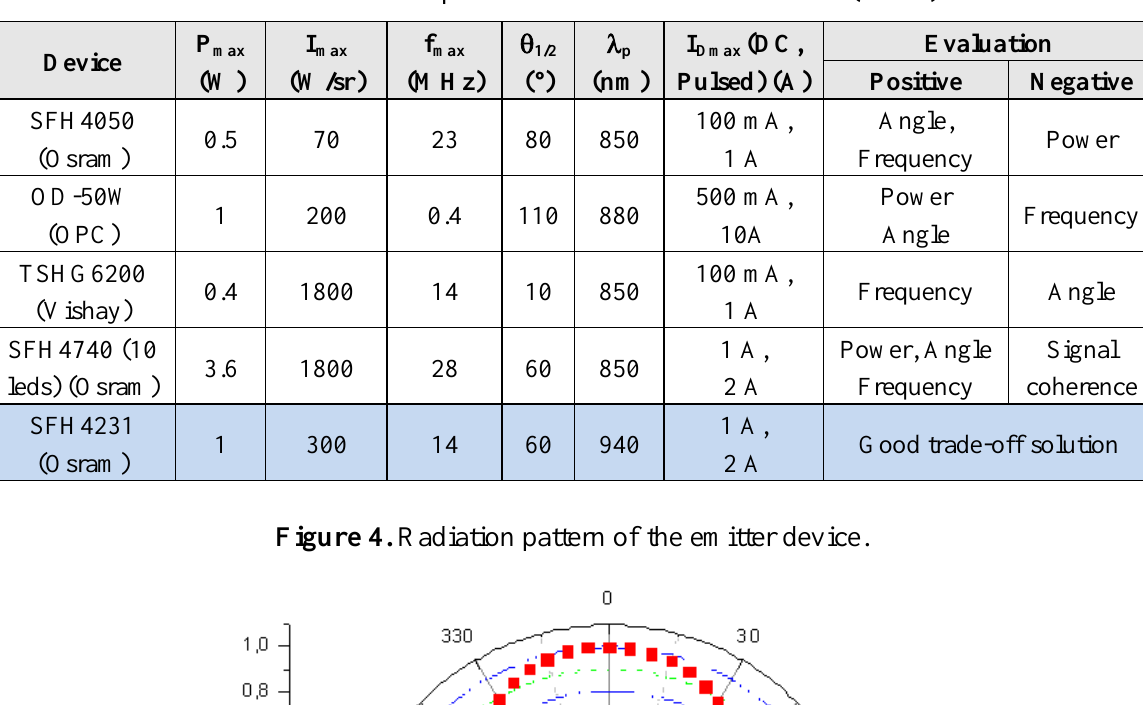
Table 1. Different up-to-date commercial IR emitters (IRED).